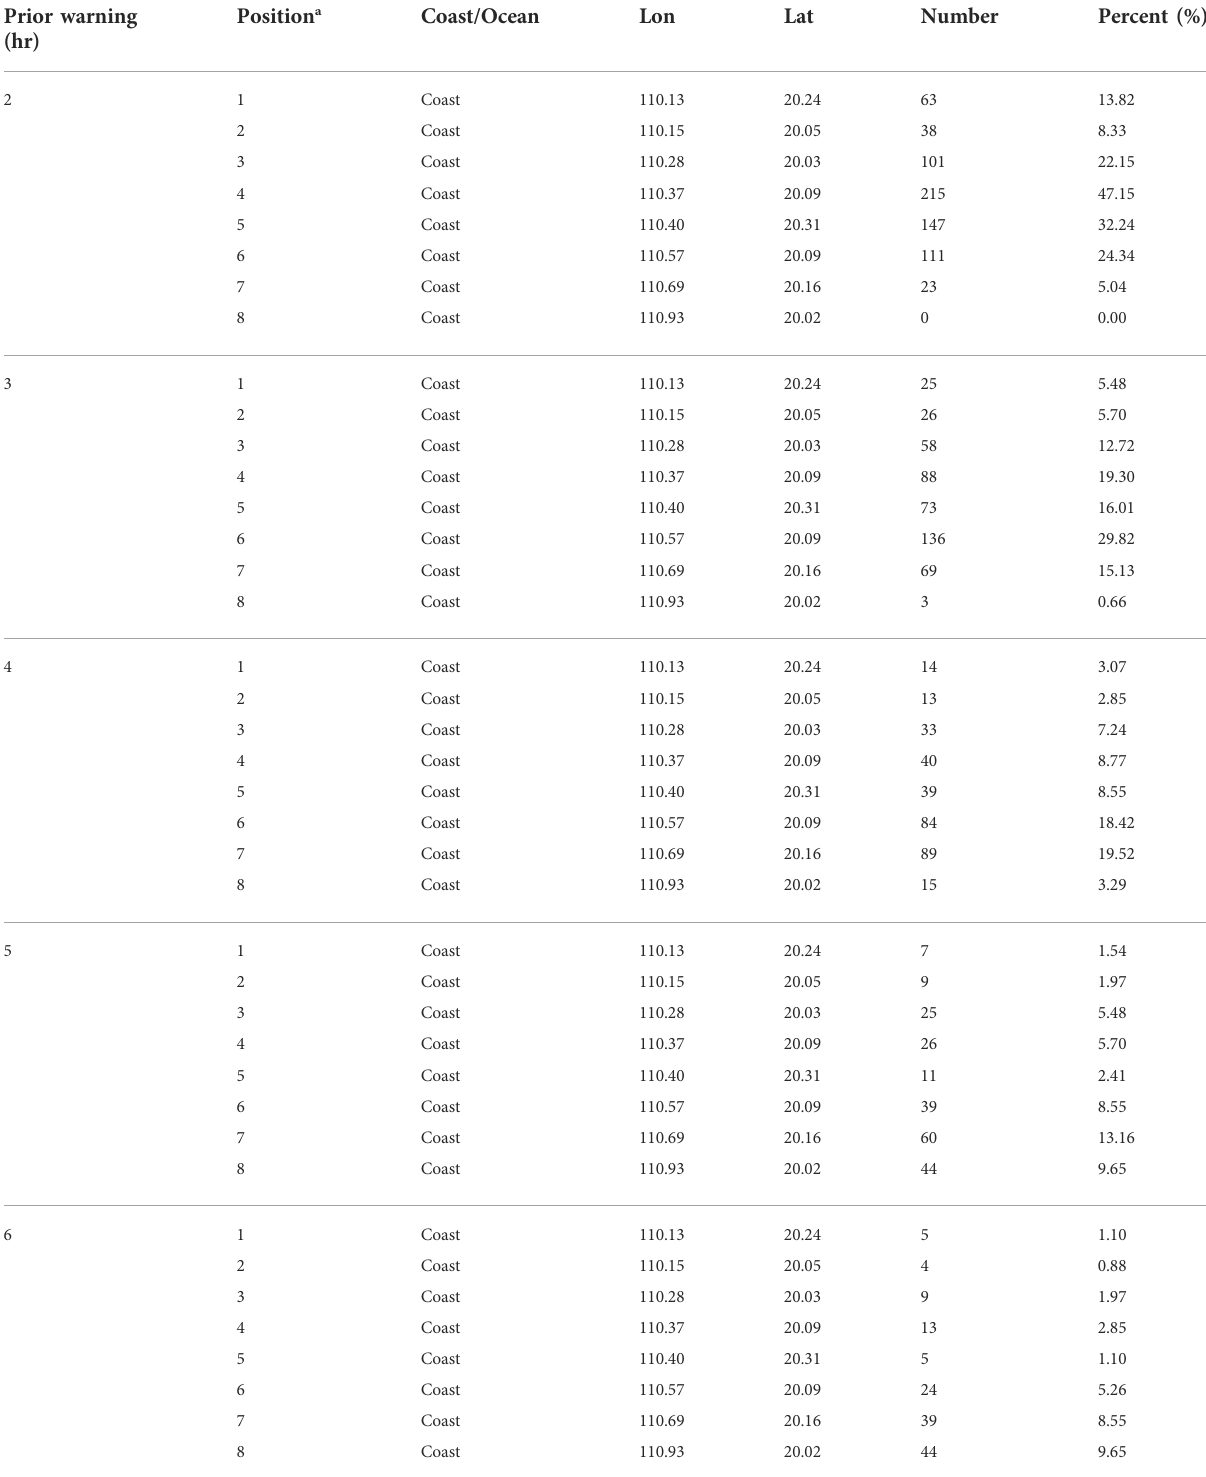
TABLE 5 Sea fog detection percentage for Xuwen harbor. Prior warning